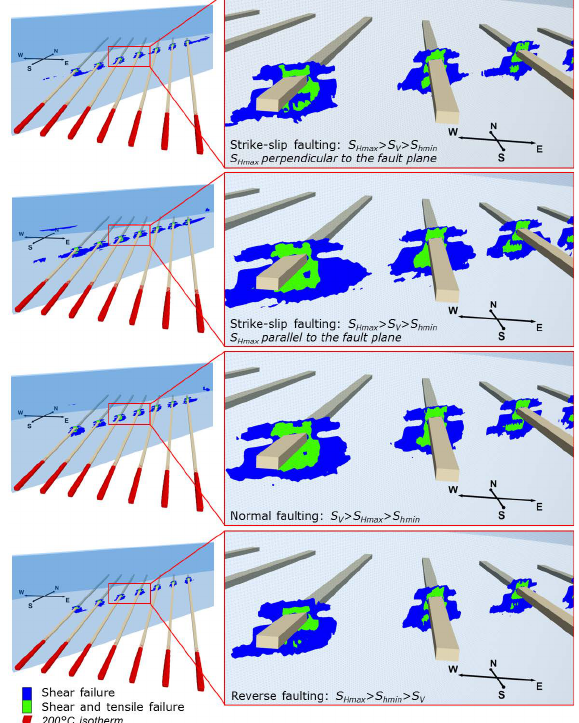
Figure 10. 3D distant ( left ) and close ( right ) views of shear and tensile failure at the fault plane in (from top to bottom) the two strike-slip (S Hmax perpendicular to the fault plane and S Hmax parallel to the fault plane) as well as the normal and reverse faulting stress regimes for the non-isothermal scenario with 140 m pillar width at a simulation time of 2000 days (end of UCG